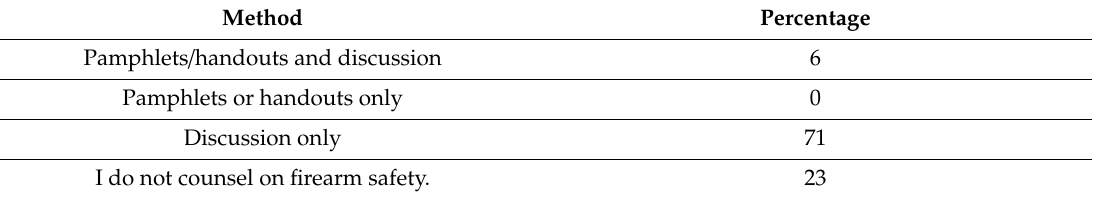
Table 3. Residents’ clinical practice regarding anticipatory guidance for firearm safety.